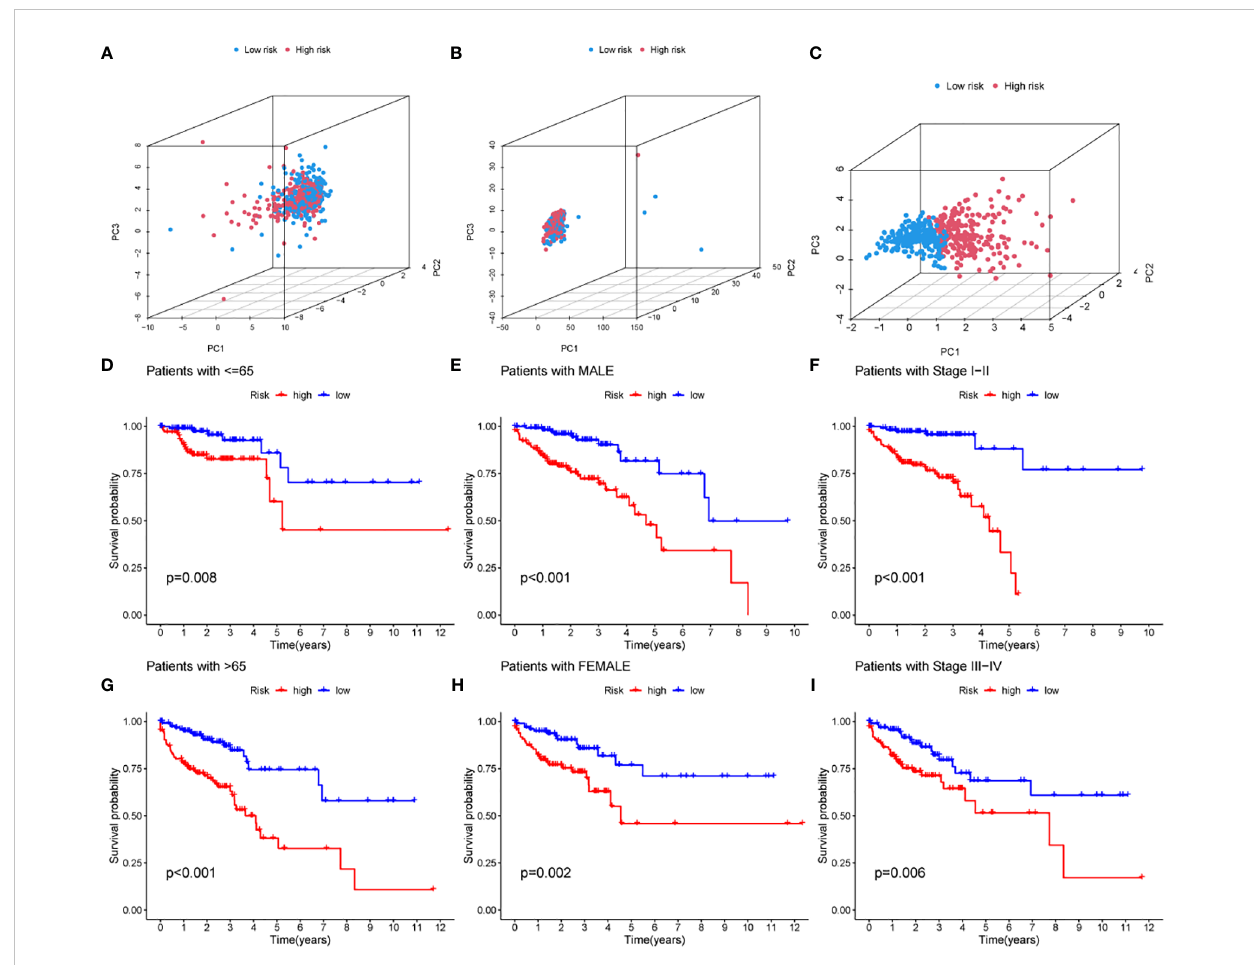
FIGURE 5 Prognostic analysis of MRLncRI in different pathological features. (A – C) PCA analysis of high-risk group and low-risk group based on HMRG, HMRG-related LncRNA and hub LncRNA. (D, E) Kaplan-Meier survival curve analysis of high-risk group and low-risk group under different age groups. (F, G) Kaplan-Meier survival curve analysis of high-risk group and low-risk group under different gender groups. (H, I) Kaplan-Meier survival curve analysis of high-risk group and low-risk group under different tumor